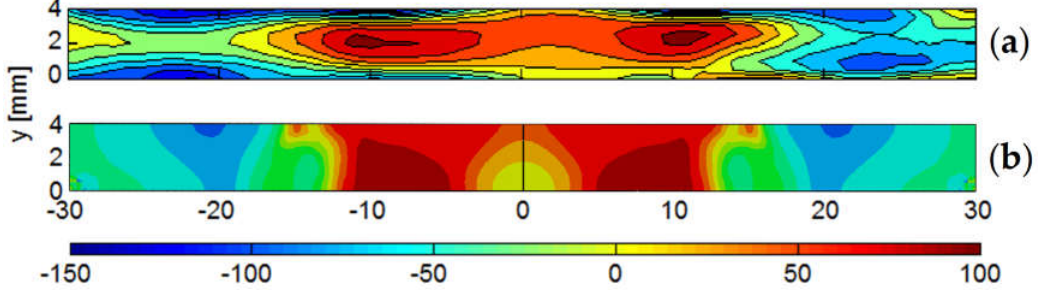
Figure 5. Comparison of the longitudinal residual stress component in the cross section of the welded specimen obtained ( a ) experimentally via the contour method; ( b ) from the numerical simulation.